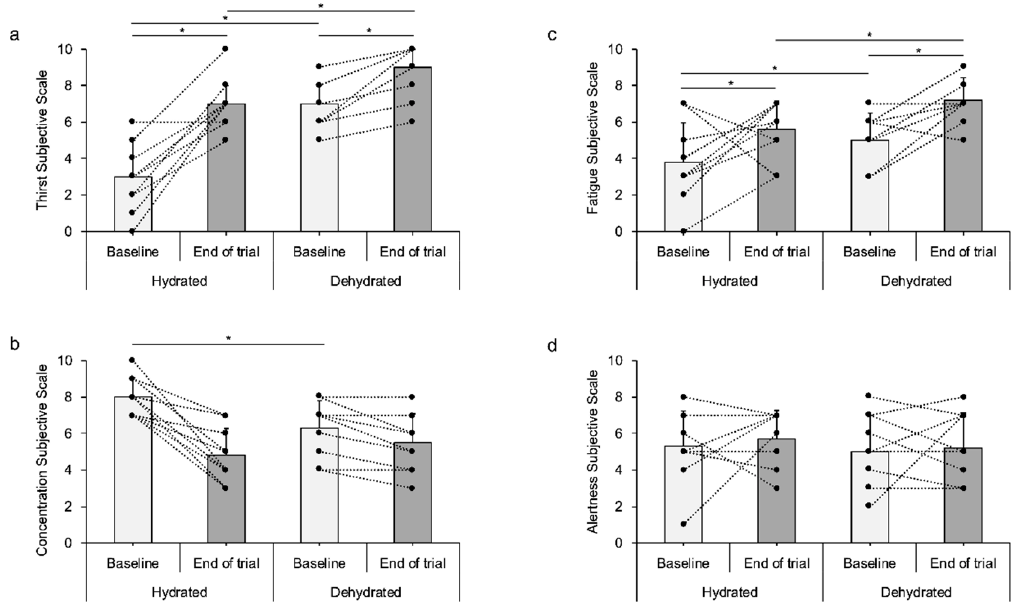
Figure 3. Subjective feelings of ( a ) Thirst, ( b ) Concentration, ( c ) Fatigue and ( d ) Alertness, at baseline and at the end of both Hydration (EUH) and Dehydration (DEH) trials. * Denotes statistically significant differences at the 0.05 level (2-tailed).